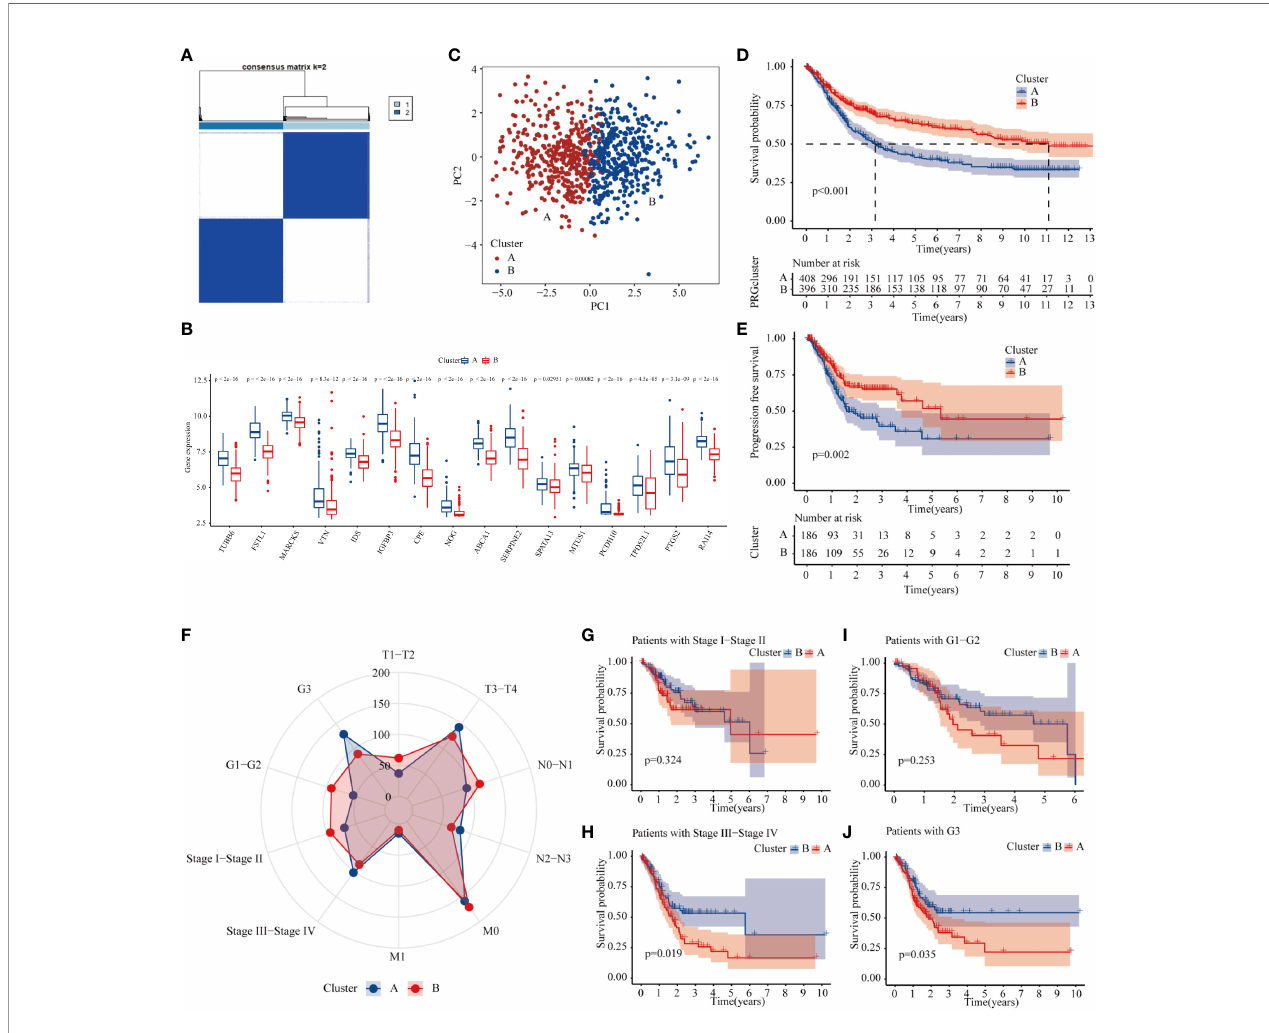
FIGURE 5 | Molecular subtype of METTL3-regulated core genes. (A) Consensus clustering of gastric cancer patients according to the expression of core genes. (B) The expression of 18 methylation core molecules in different GC subtypes. (C) PCA plots of subtype. (D, E) K-M curves of overall survival and progression-free survival of gastric cancer patients with different subtypes. (F) The number of patients at different T, N, and M stages and grades in different GC subtypes. (G – J) The prognosis of Stage I – Stage IV and G1 – G3 GC patients in different GC